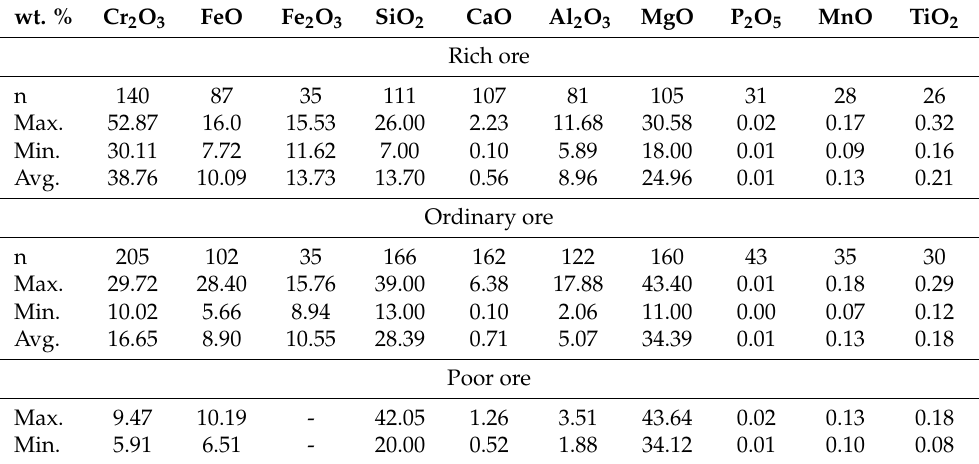
Table 1. Average chemical composition of poor, ordinary and rich Cr-spinel ores of the Sopcheozero deposit (wt.%) [1]. wt. % Cr 2 O 3 FeO Fe 2 O 3 SiO 2 CaO Rich ore